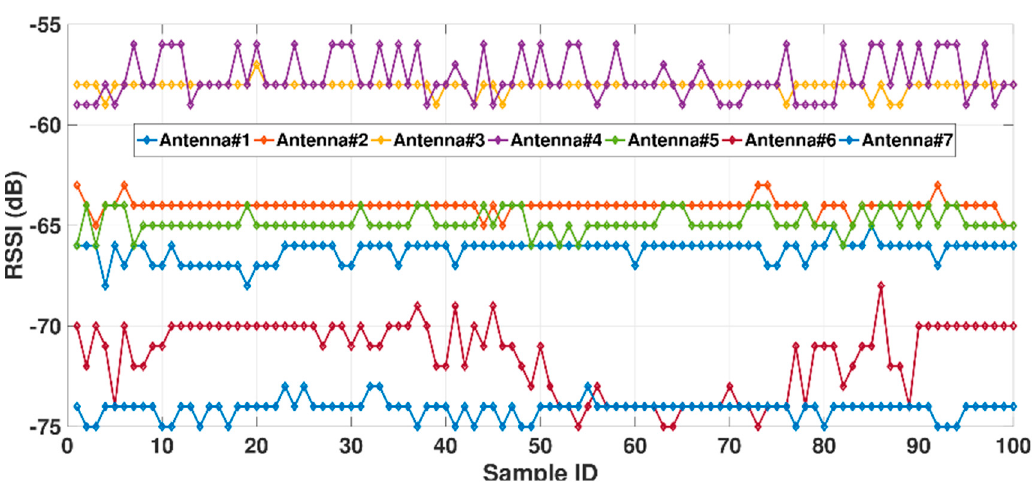
Figure 10. Typical Received Signal Strength Indicator (RSSI) acquisition trace: case C, anchor installed at room up-right corner (5.75, 5.00) m.